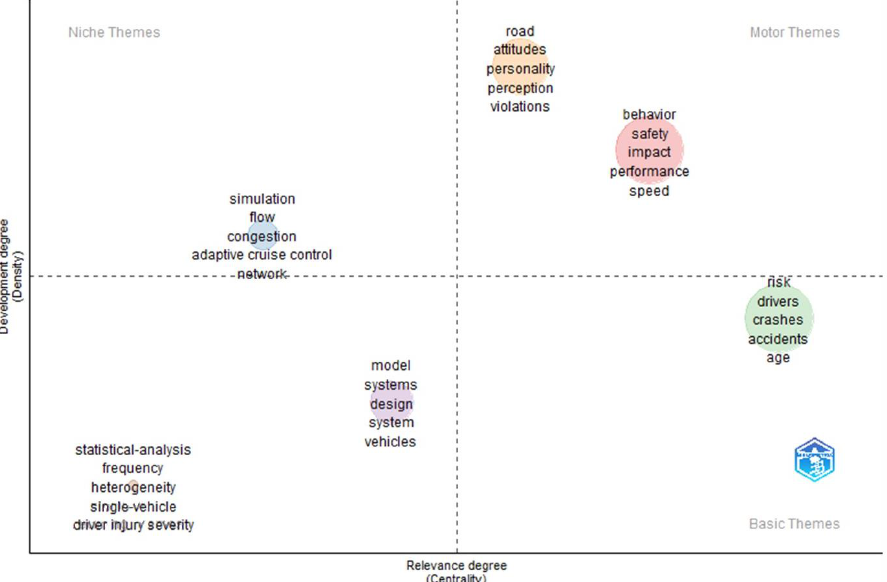
Figure 11. Thematic map of driver behaviour and traffic safety globally. Source: Author’s own, based on Web of Science search (Walktrap Clustering Algorithm, Minimum Cluster Frequency 5/1000 documents, 250 keywords).